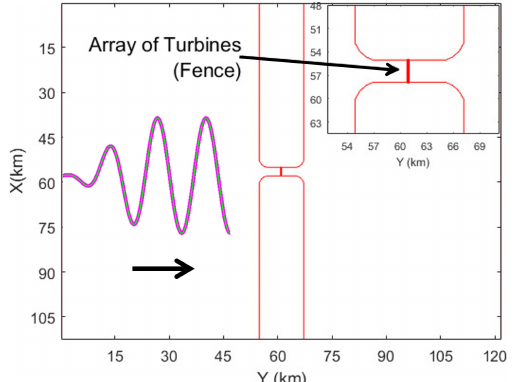
Figure 2. Tidal channel model domain. A channel zoom out (upper-right location) shows the array of turbines deployed. Forcing implemented is represented by the ramping up elevation in